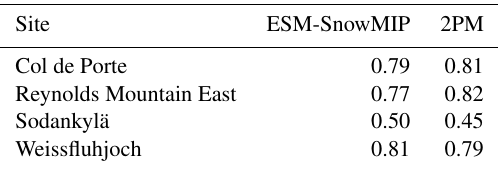
Table 2. Average correlations between simulated annual snow cover duration and annual